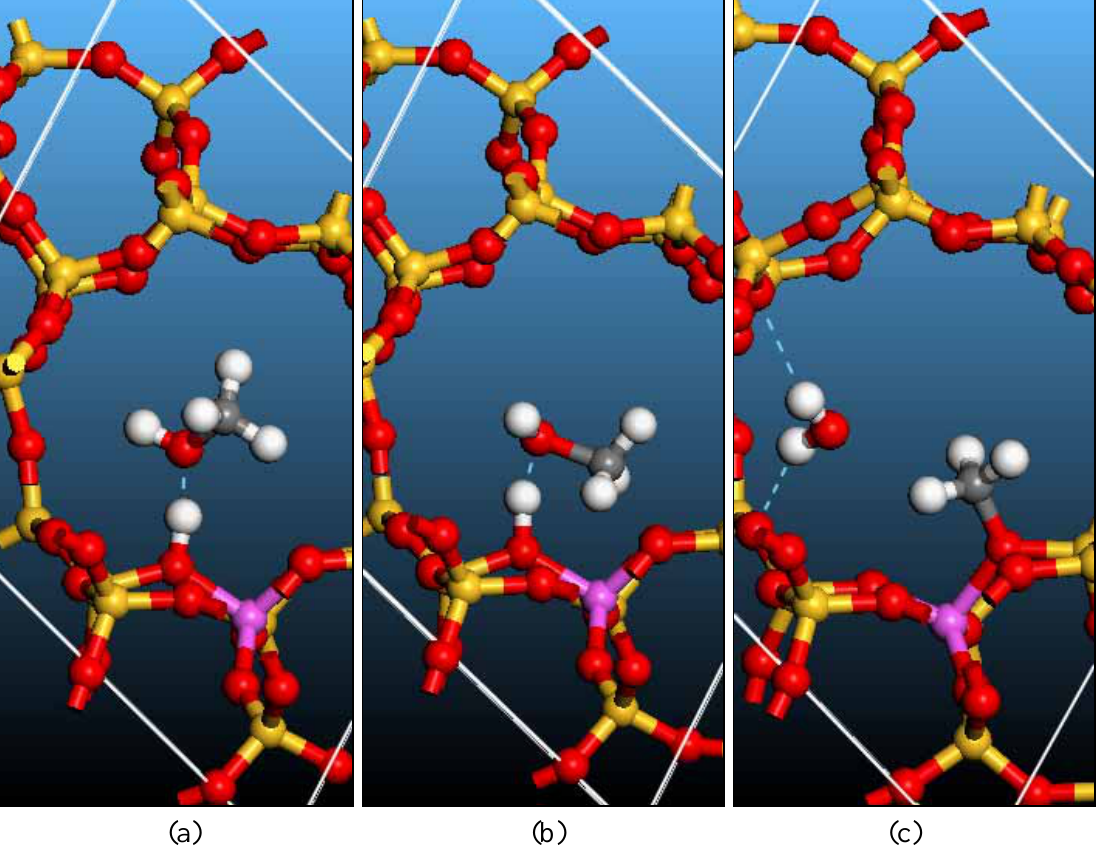
Figure 2. Surface methoxyl formation with a single methanol molecule via a strained S reaction. (a) Hydrogen-Methanol complex at the Brønsted acid site, (b) Transition state structure, (c) Surface methoxyl. Dotted lines represent hydrogen